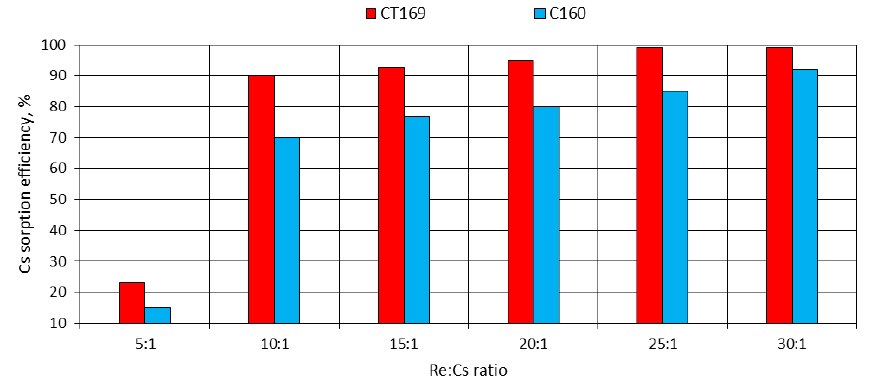
Figure 4. Influence of rhenium-to-cesium ratio on cesium ion elution efficiency.